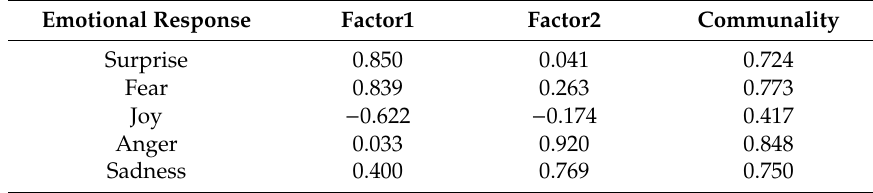
Table 3. Result of Principal Component Analysis of Emotional